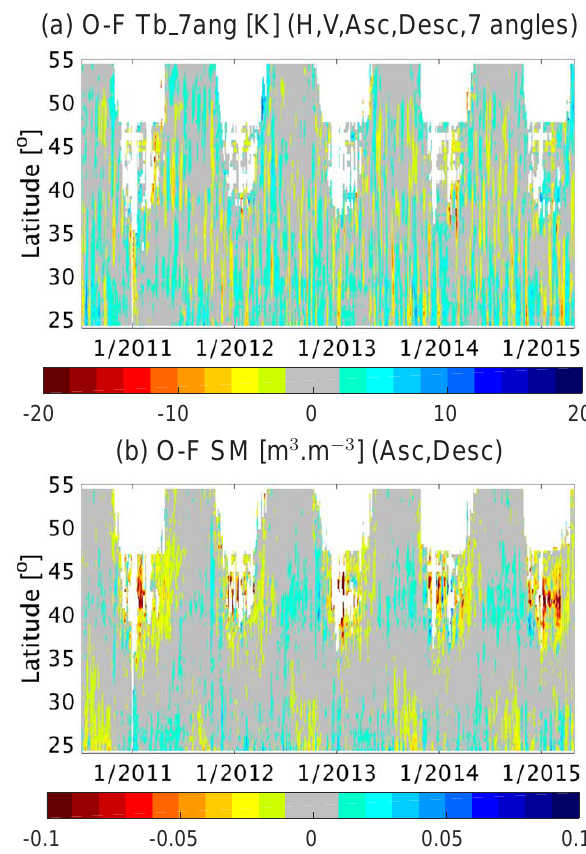
Figure 5. Hovmüller plots showing the temporal evolution of lon- gitudinally averaged innovations (O–F) for the period from 1 July 2010 to 1 May 2015. (a) Tb_7ang innovations, averaged over H - and V -polarization, ascending and descending swaths, and over seven incidence angles. (b) SM innovations, averaged over ascend- ing and descending